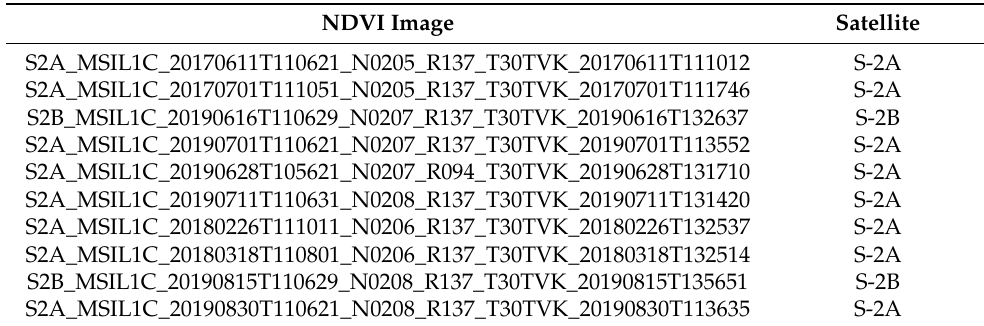
Table 2. The Sentinel-2 images used in the present work to calculate the